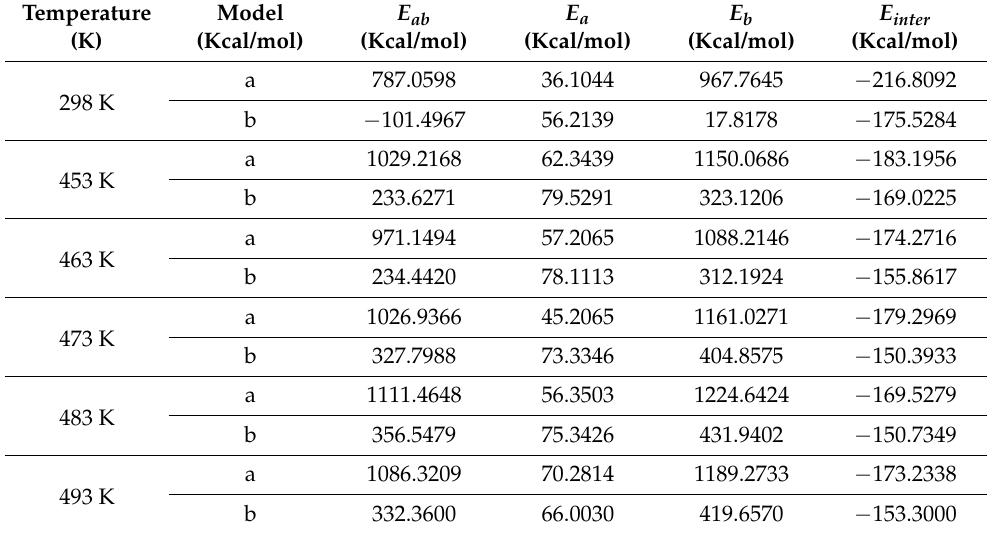
Table 1. Interaction energy of formaldehyde with cellulose and cellulose–acetate molecules in different temperature